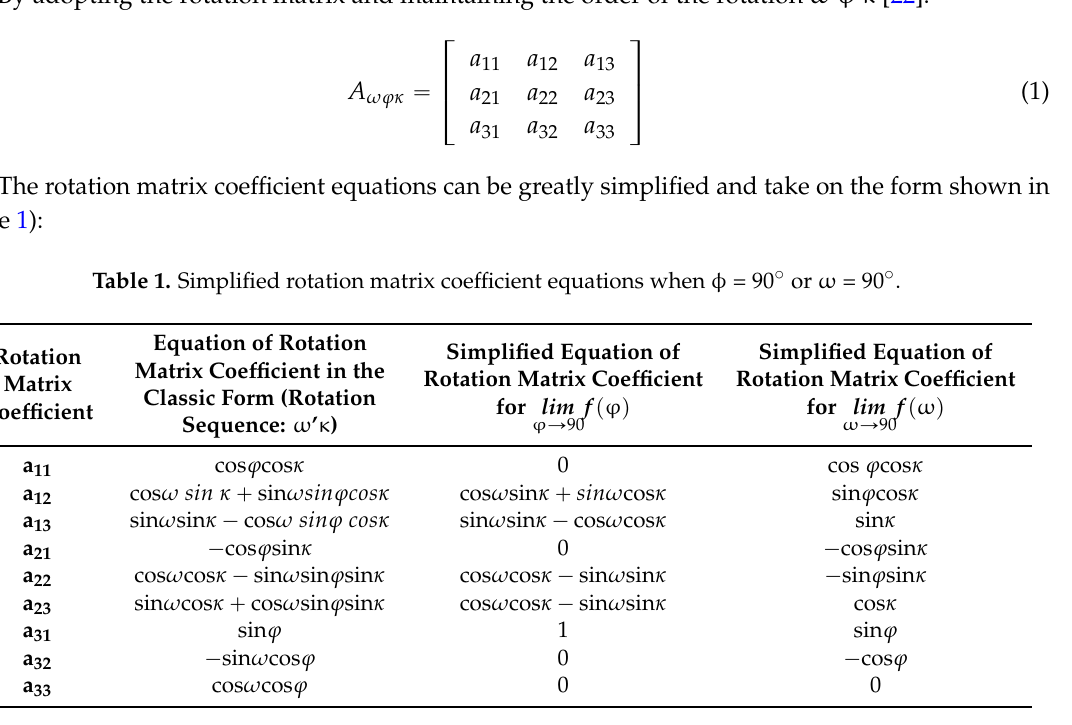
Table 1. Simplified rotation matrix coefficient equations when φ = 90° or ω = 90°.